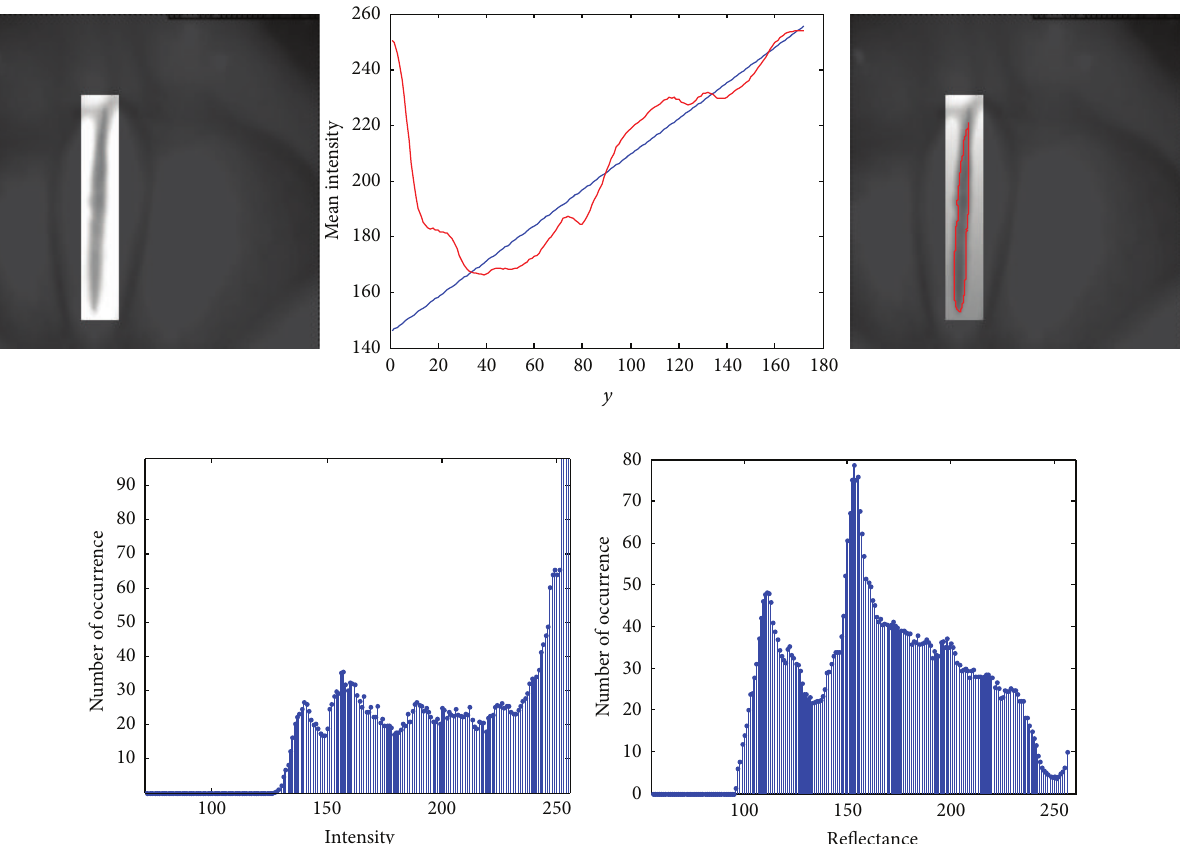
Figure 15: Illumination modeling system (reflectance is scaled by 255 for grayscale